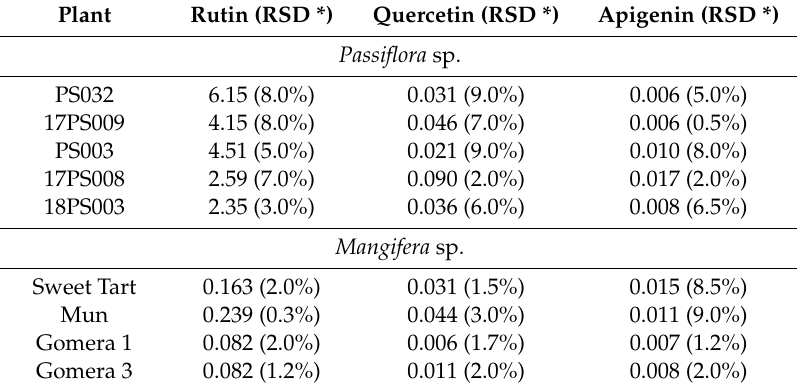
Table2. Flavonoidscontent(in mg · g − 1 )of passionfruitandmangoleaves fromCanary Islands, analyzed by the proposed IL-MA-SLE-HPLC-PDA method, using an aqueous solution of the [C 10 Gu + ][Cl – ] IL-based surfactant as extractant. Plant Rutin (RSD *) Quercetin (RSD *) Apigenin (RSD *) Passiflora sp.